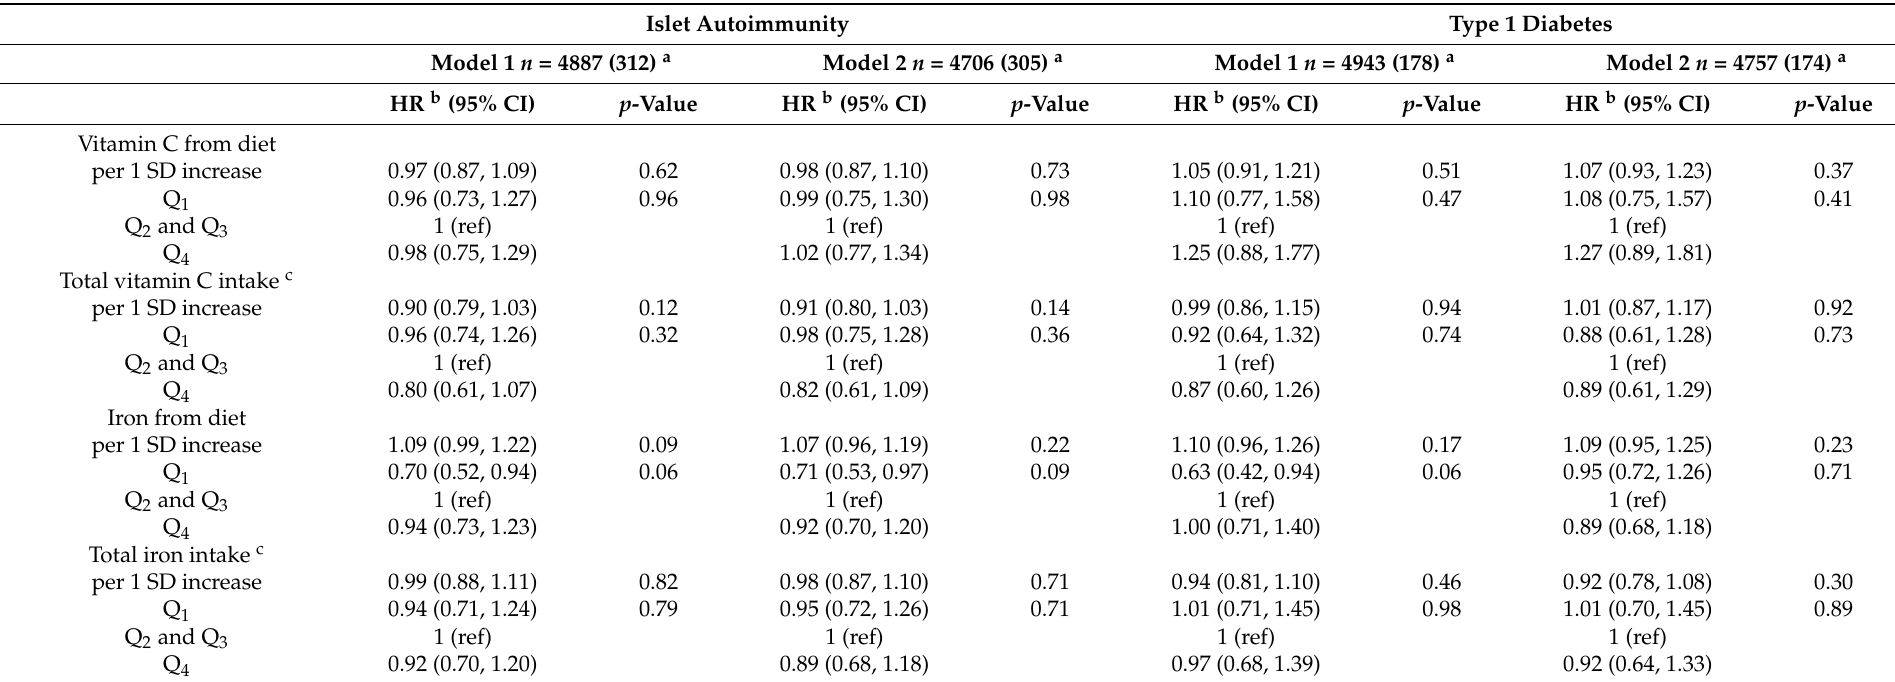
Abbreviations: Q1–Q4, quarter. a n represents total number in the analyses and number in parenthesis represents numbers of children with the outcome. b HRs (95% CI) are from Cox regression analysis ( p values from Wald test). c Total vitamin C and total iron intake from diet and dietary supplements. Model 1: Energy adjusted with the Willett’s residual method. Model 2: As model 1 and further adjusted for sex, family history of diabetes HLA